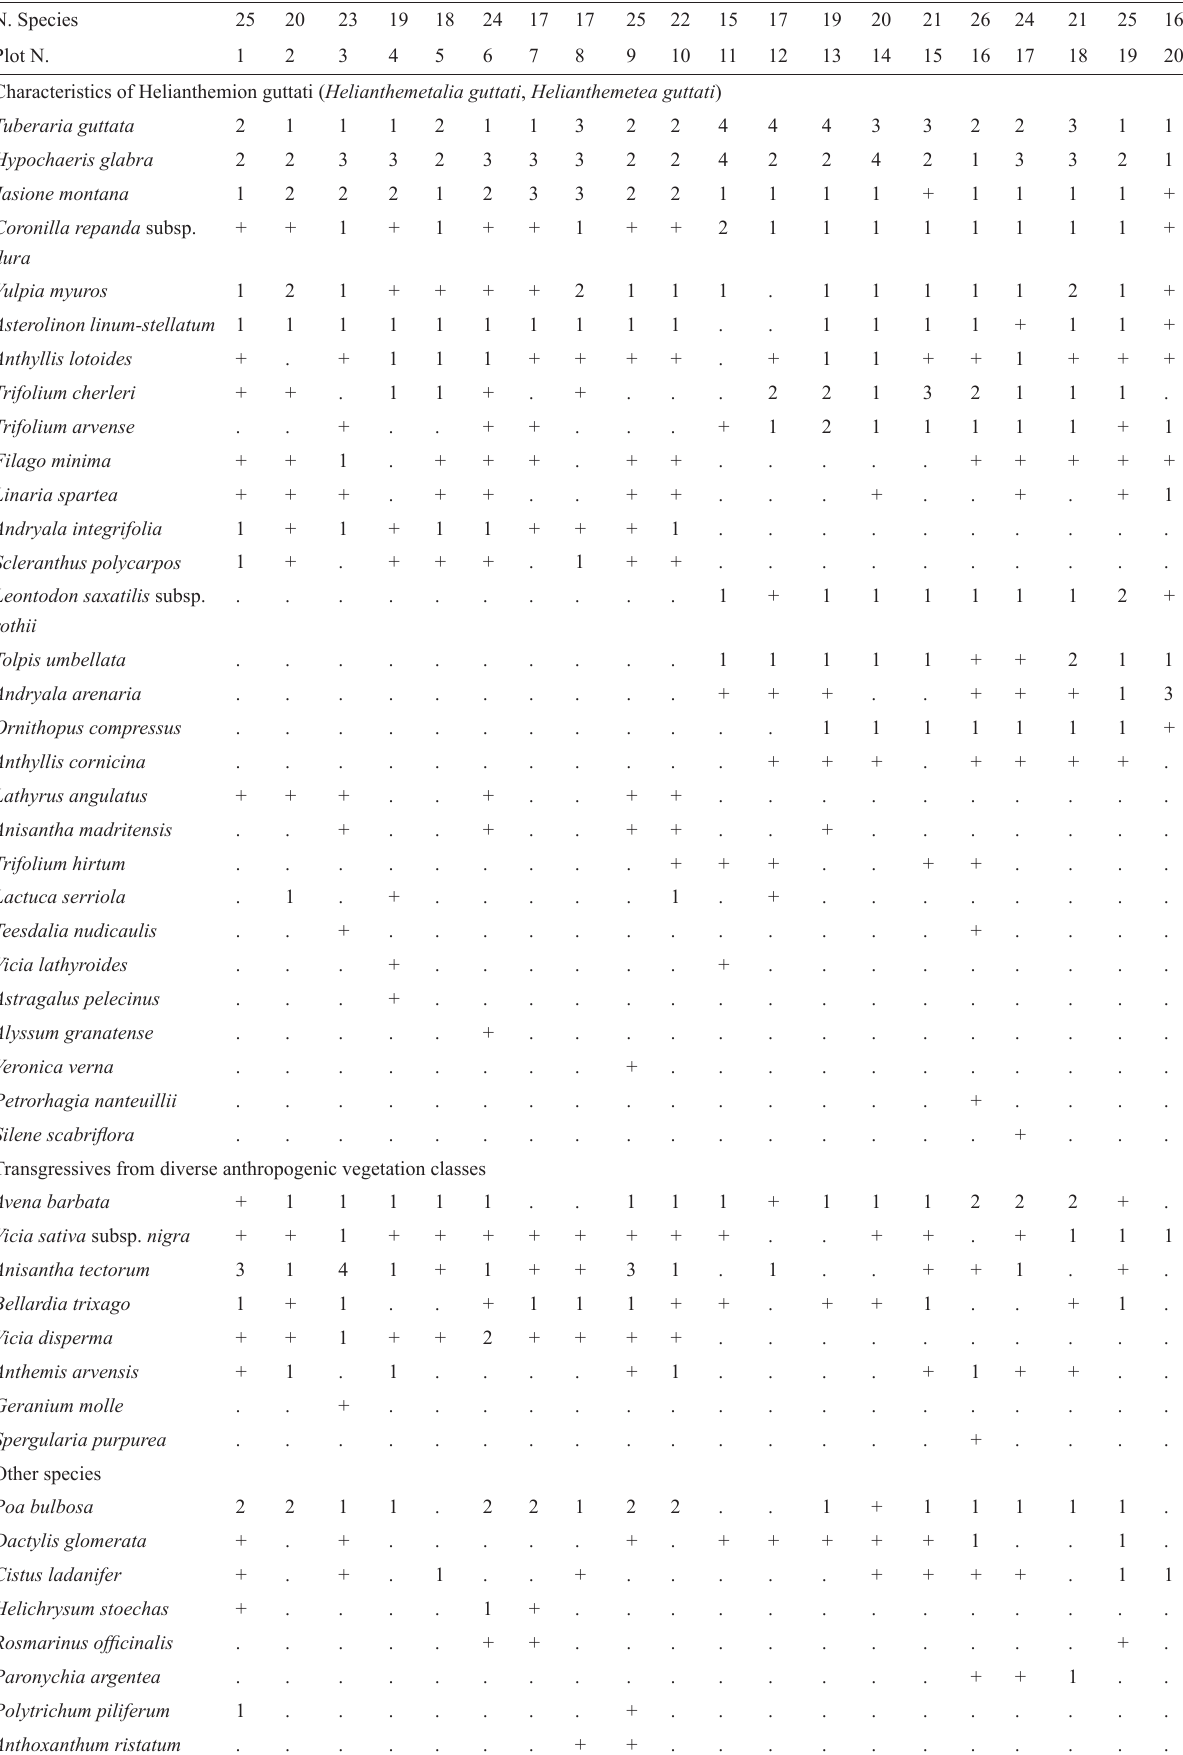
Table 7. Plots recorded in the “Solana de los Quejigos” area (QB, burned). For all plots, the altitude is 1000 m asl. Indexes correspond to those of Br.- Bl. 1964. See text for more explanations on plant communities and